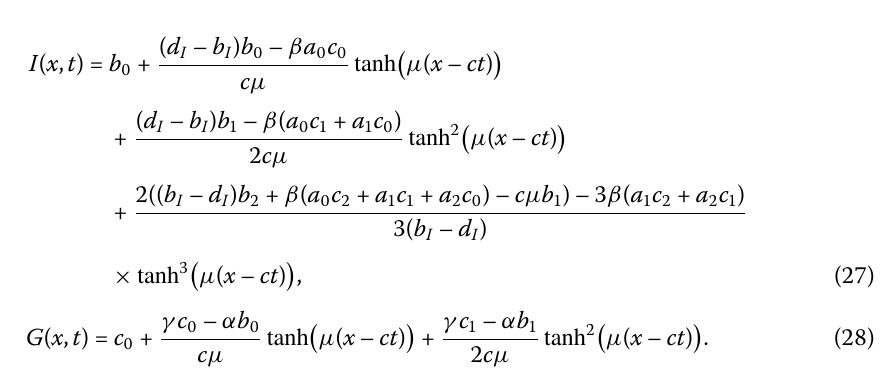
Figure 2 Travelling wave solution. (a) The susceptible population per unit area and (b) the infected population per unit area are plotted as functions of x for t between 30 (left most) and 60 (right most), plotted in time steps of 10. Here, S (0,0) = 0.4, I (0,0) = 1.285451998, G (0,0) = 0.8186870039, and other parametric values are as given in the